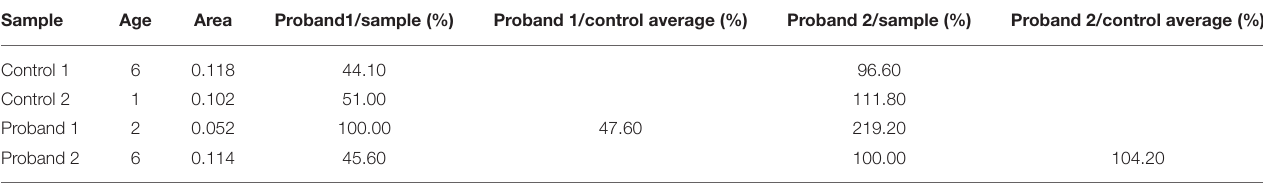
TABLE 3 | RT-Q-PCR analyses of RNA expression from probands 1 and 2 relative to age-matched controls using primer pair 3 located at exons 5 and 6 of STXBP1 .